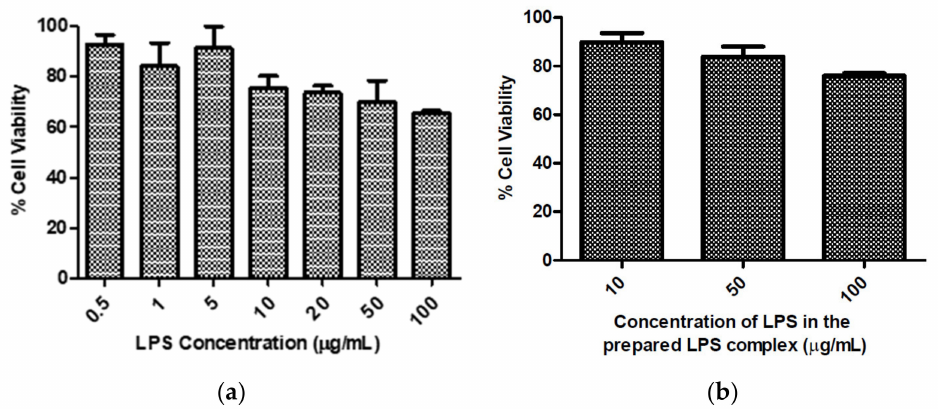
Figure 4. HCECs were treated with ( a ) range of different concentration of LPS and ( b ) LPS complex for 24 h, where the values on the x-axis are the concentration of LPS in the LPS complex prepared as per Section 2.2.4. Viability of untreated cells were taken as 100%. Viability of the cells decreased with increasing concentration of LPS. Results represent n = 3 ±